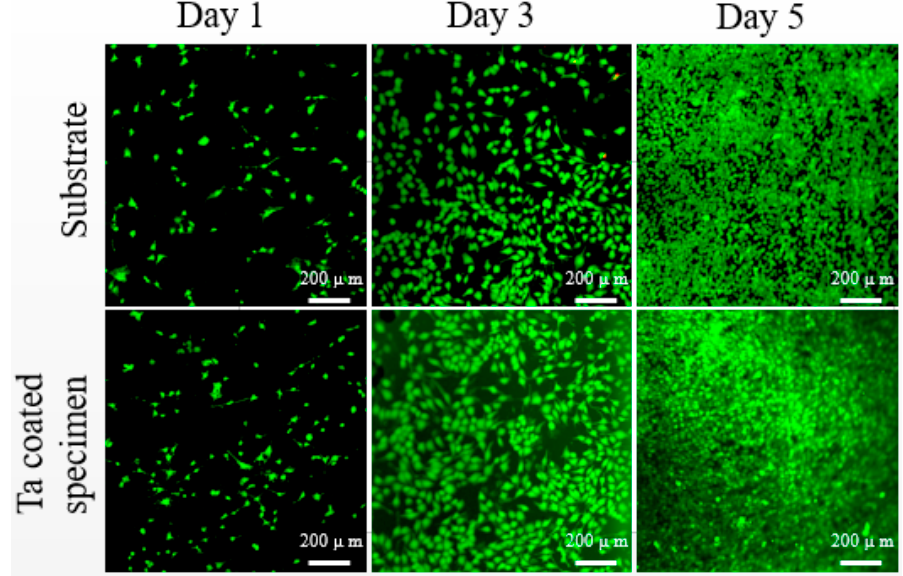
Figure 8. Fluorescence images of Live/Dead staining of osteoblasts culturing on the uncoated and Ta coated specimens for 1, 3 and 5 days.